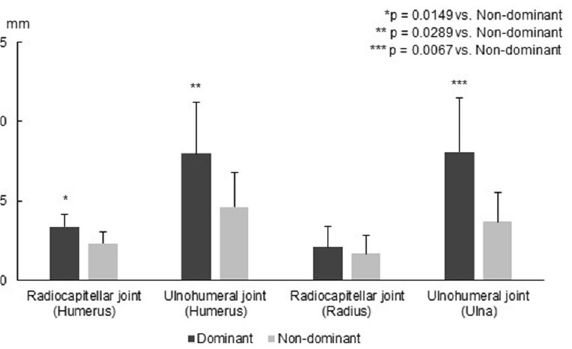
Figure 2. The translation distance of the joint contact area centroid from the position without elbow valgus stress to the position with elbow valgus